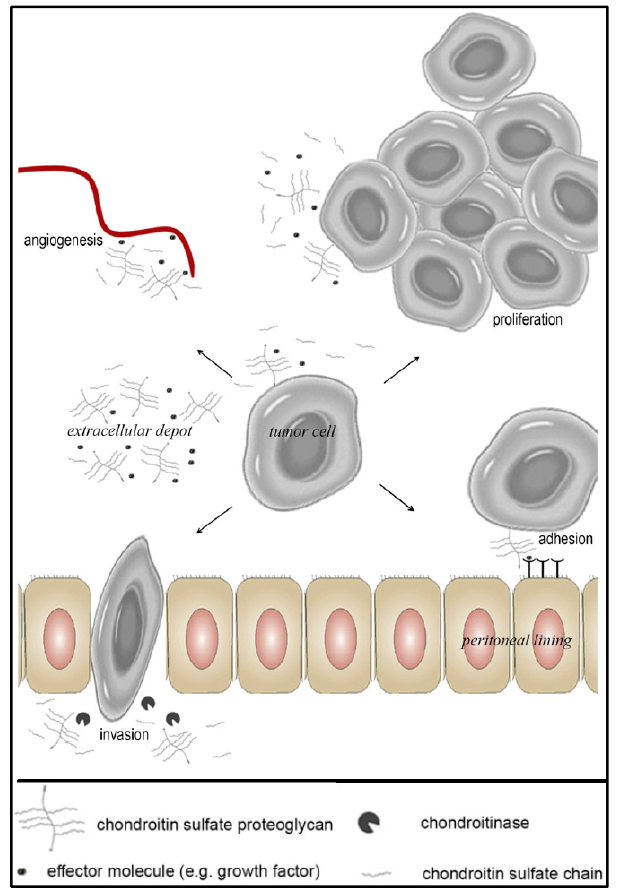
Figure 3. Processes in ovarian carcinogenesis in which chondroitin sulfate plays a critical role (Reference [7]; Reproduced with permission from Elsevier B.V. Ltd. © 2014).